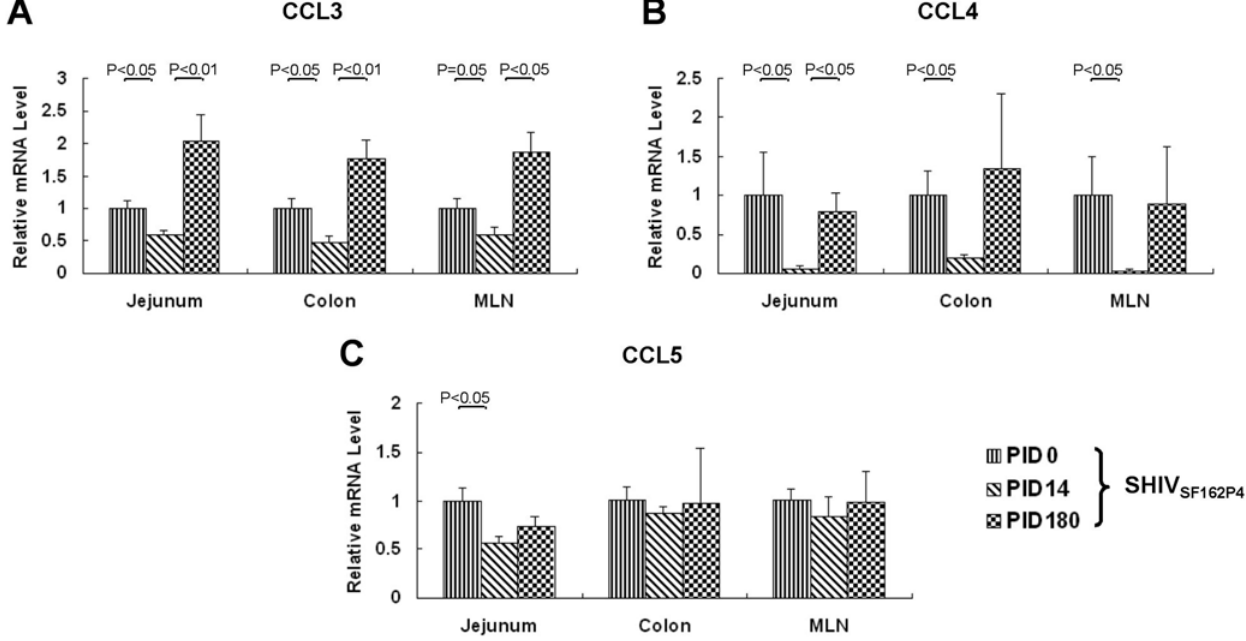
Figure 2. Relative CCL3 (A), CCL4 (B) and CCL5 (C) expression levels in GALT tissues at different stages of SHIV SF162P4 infection (n=5). PID 0 was used as the calibrator (value=1).